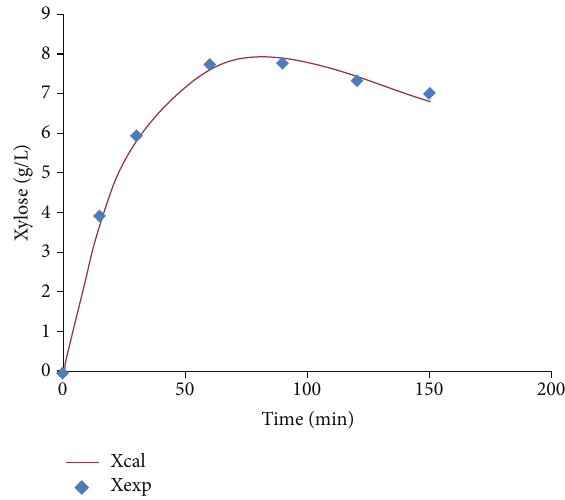
Figure 2: Comparison between calculated and experimental value of xylose in hydrolysis of OPEFB with 4 % H 2 SO 4 at 120 ∘ C